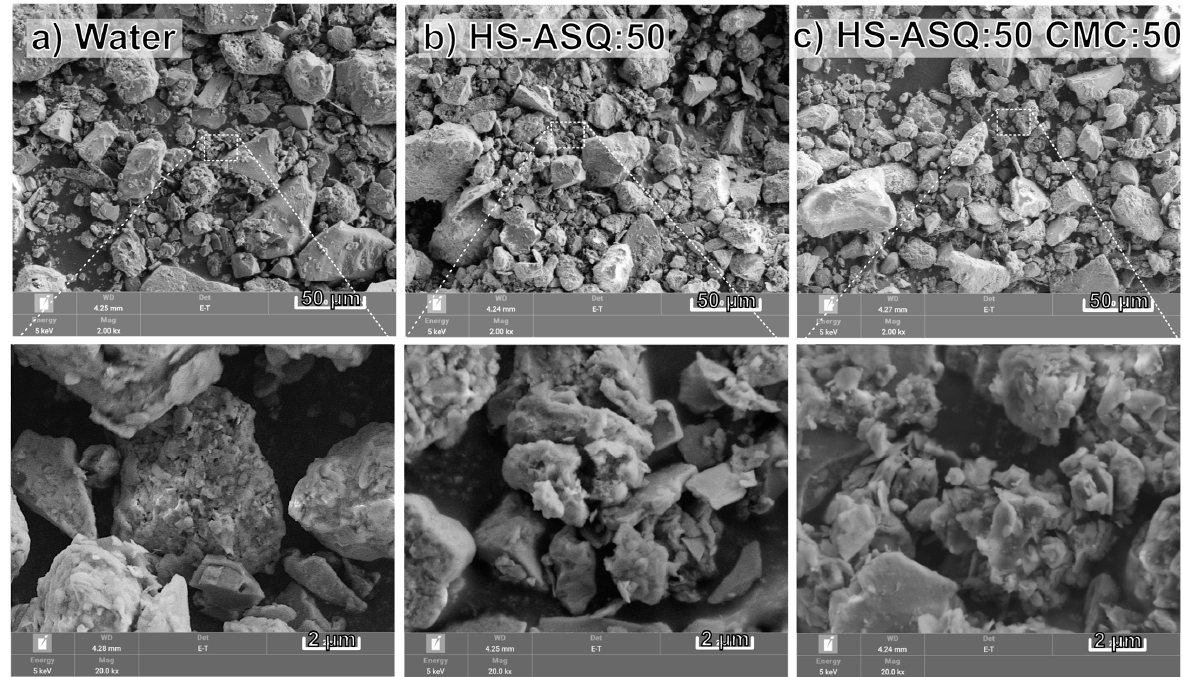
Figure 7. SEM images: surface morphology of dust particles treated with water ( a ), HS–ASQ:50 ( b ), and HS–ASQ:50 CMC:50 ( c ).